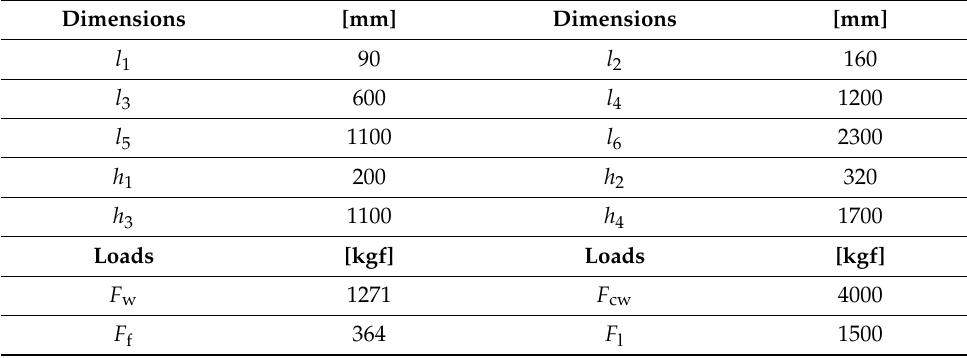
Figure 18. Example of a step of the structural analysis performed using Solidworks: frame displace ‐ ments.